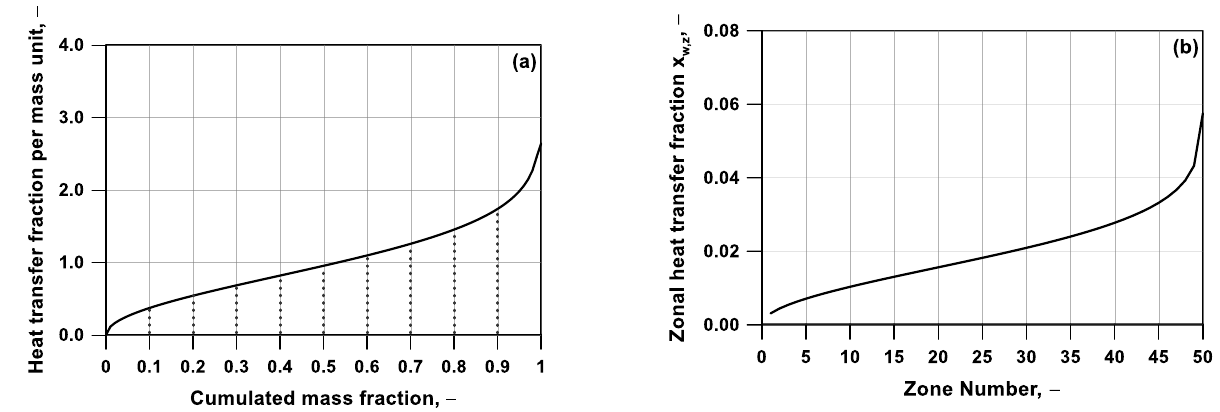
Figure 3. Distribution of heat transfer fraction per unit mass versus the cumulative mass fraction ( a ) and the corresponding zonal heat transfer fraction ( b ).